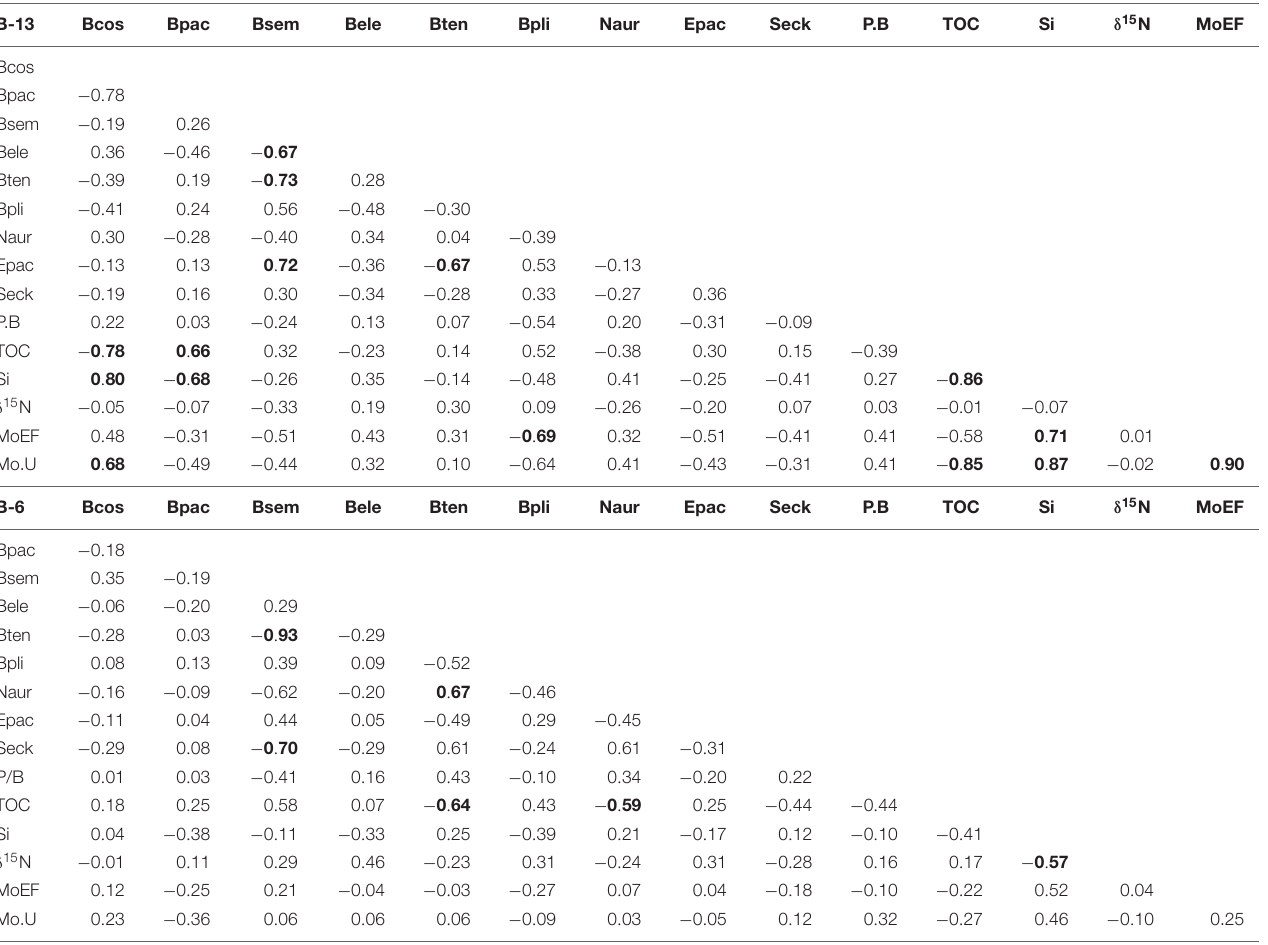
TABLE 2 | Spearman correlation matrix for biogenic and geochemical proxies from B-13 and